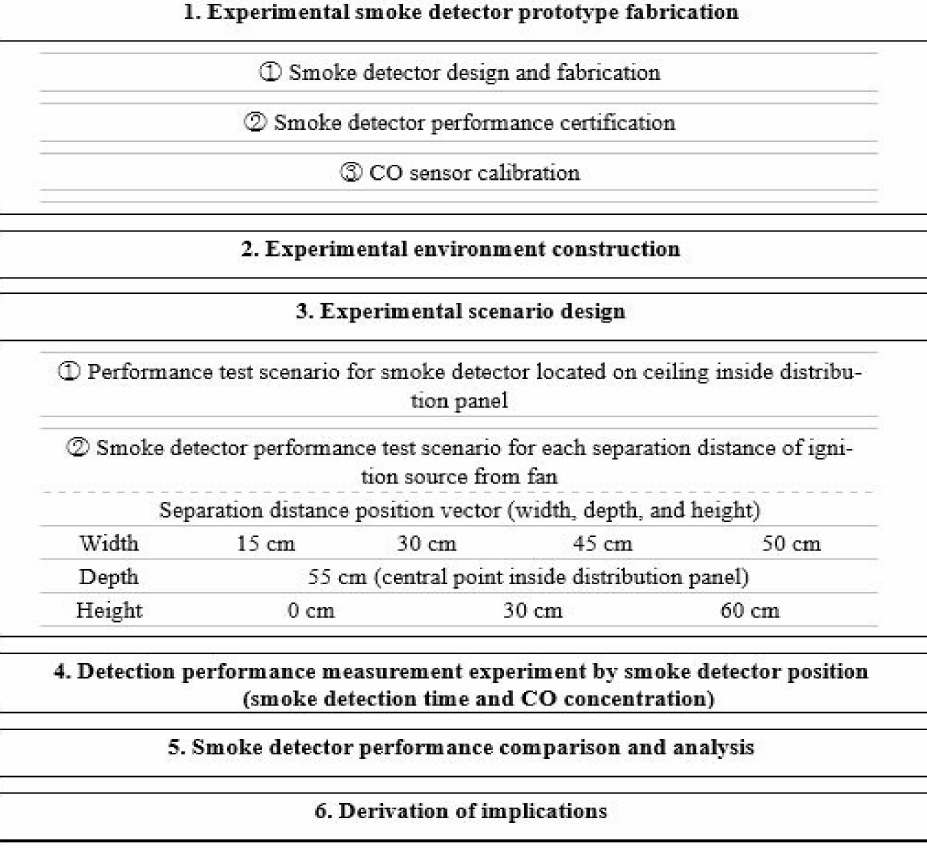
Figure 1. Research